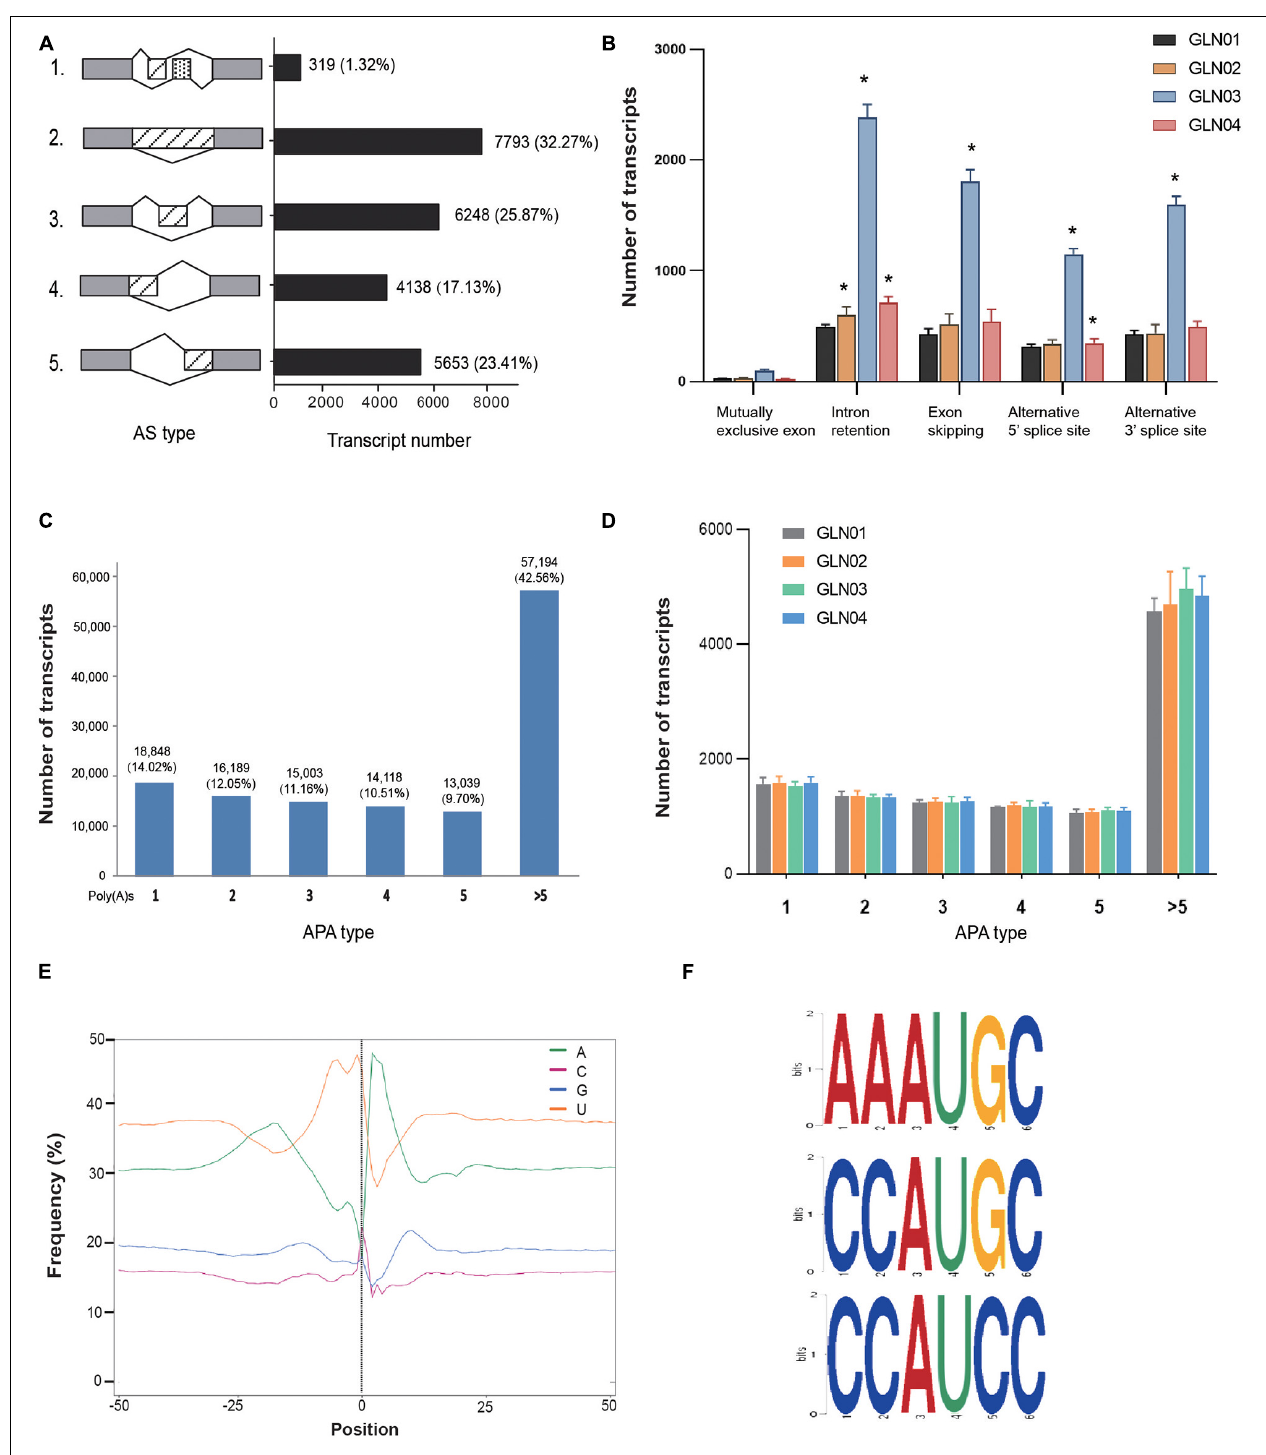
FIGURE 2 | Identification of AS and APA events. (A) Numbers of various AS events and their corresponding proportions based on 12 full-length transcripts. (B) AS events and corresponding transcript numbers across four developmental stages (GLN01–04) of G. luofuense stems. (C) Numbers of transcripts that possess various numbers of poly(A) sites based on 12 full-length transcripts. (D) APA events and corresponding transcript numbers across four developmental stages (GLN01–04) of G. luofuense stems. (E) The nucleotide composition around poly(A) cleavage sites, with the relative frequency of each nucleotide on the y -axis and the transcriptome composition across all poly(A) cleavage sites on the x -axis. (F) Three conserved motifs found in the 50 nt upstream region of the poly(A) cleavage site in all full-length transcripts. Symbol * indicates the p values < 0.05 using Student’s t-test analysis.